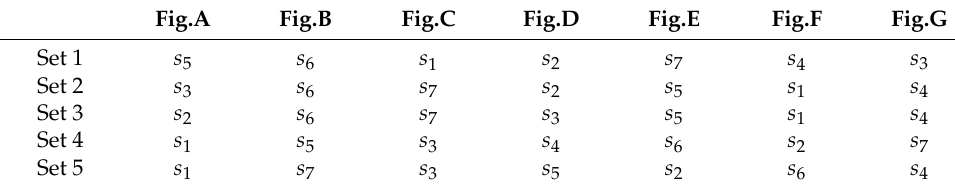
Table 4. Answers for calibration experiment of DM 4 .